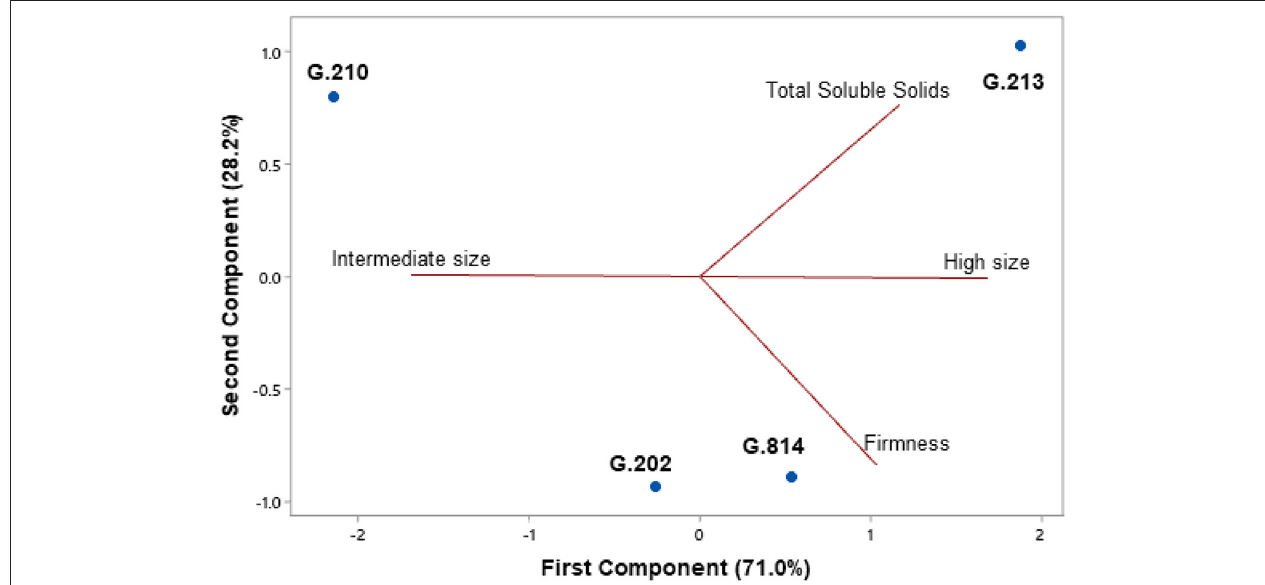
FIGURE 11 | Fruit quality analysis of the Gala Select cultivar on the Geneva ® series rootstocks. Vacaria - RS.